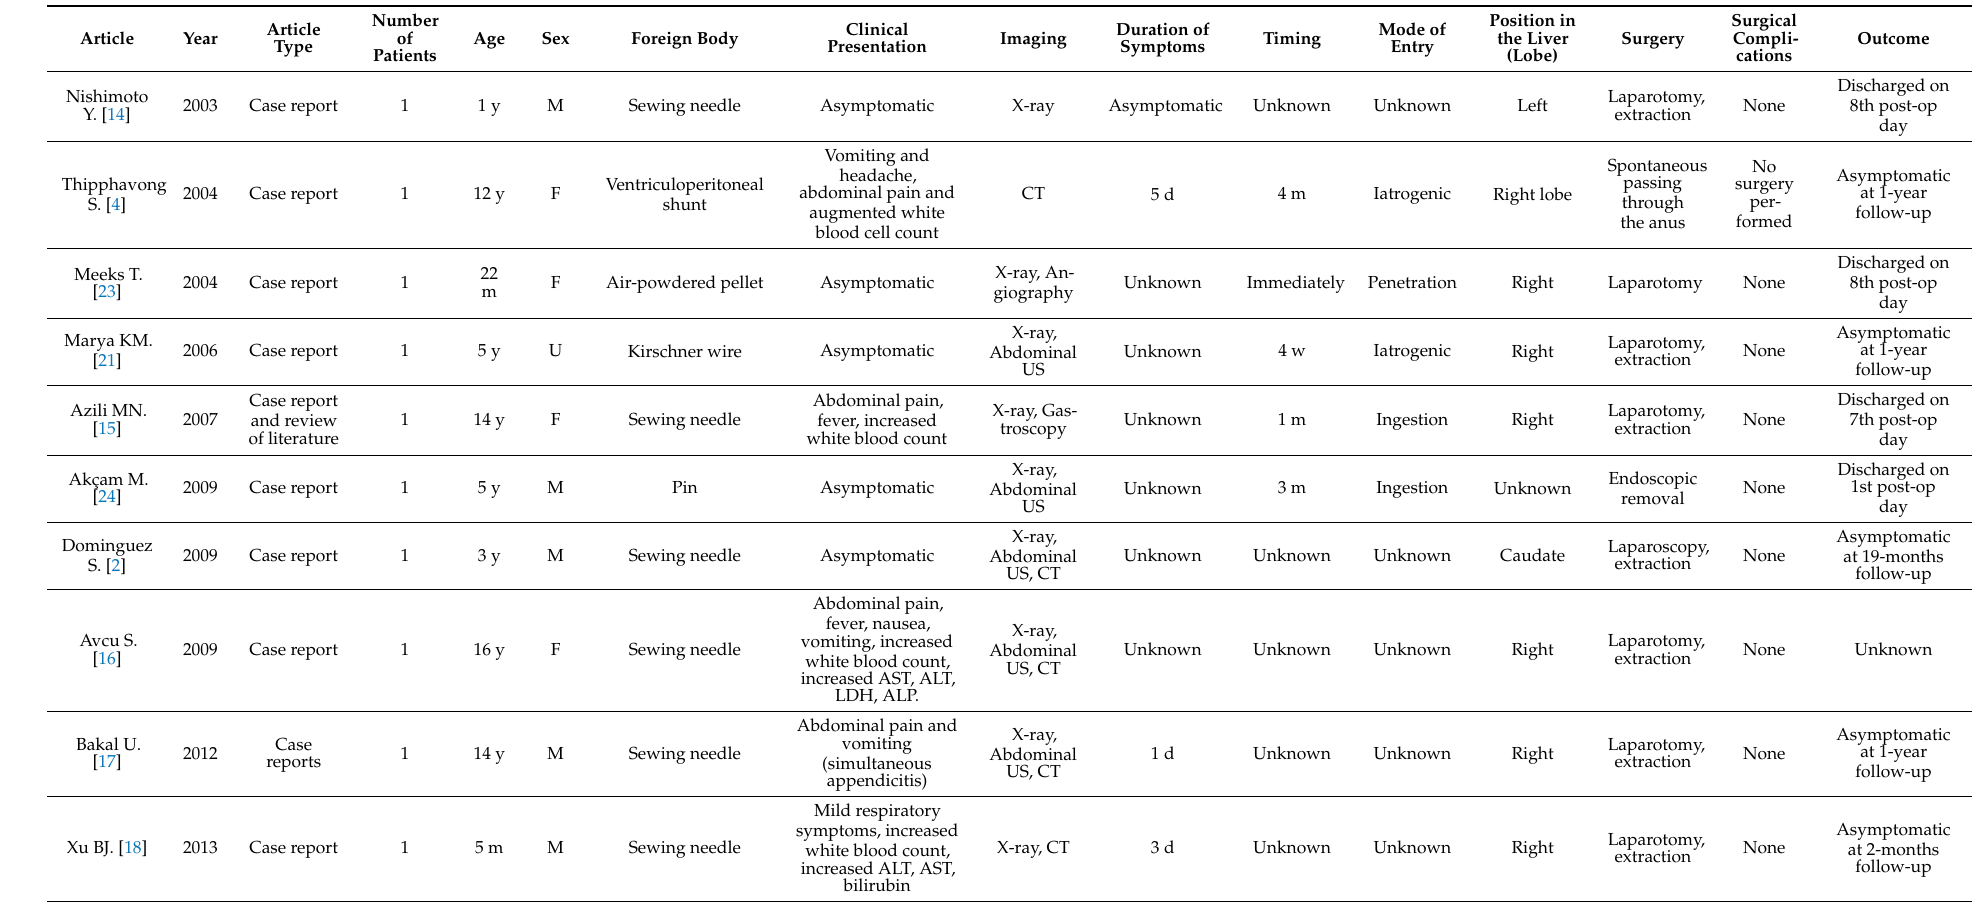
Table 1. List of papers included in the review and findings.